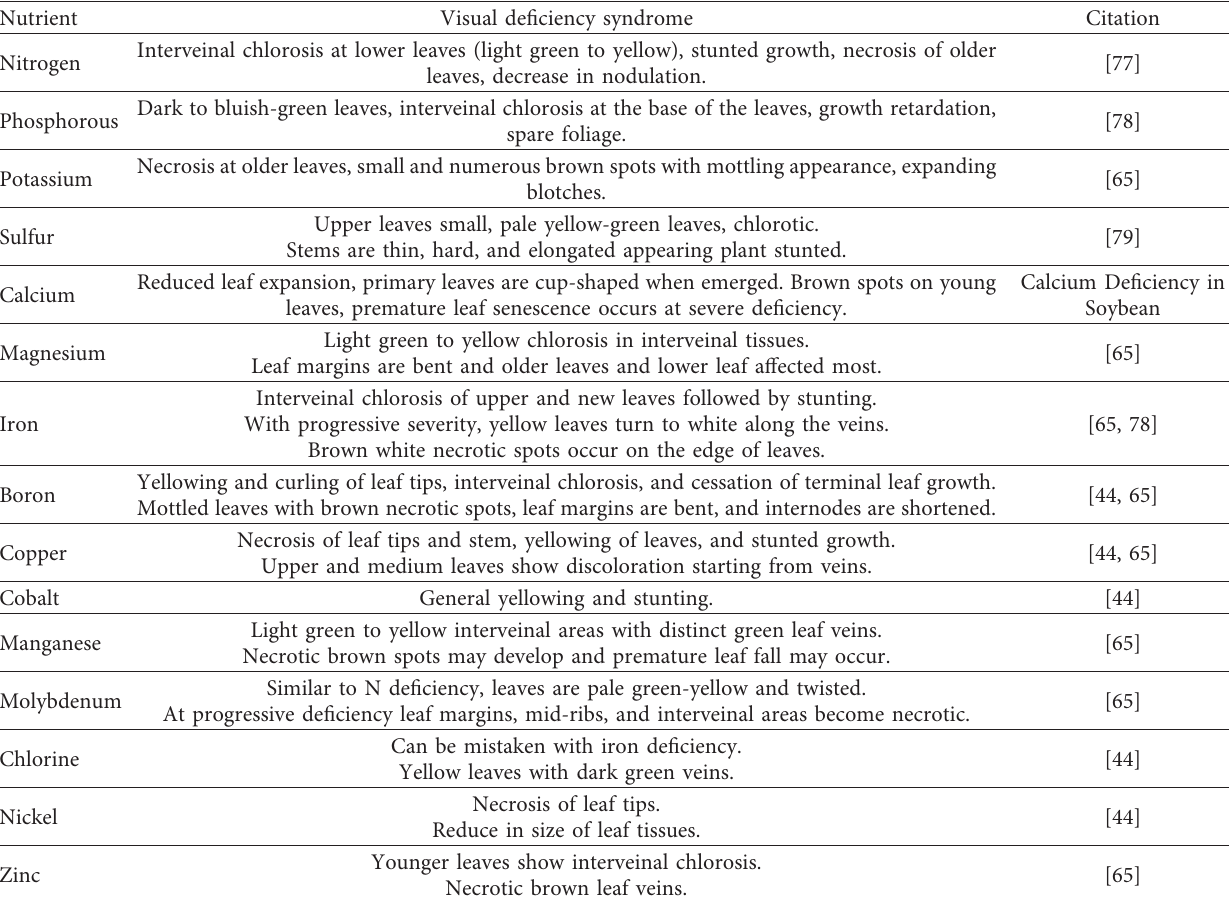
Table 1: Visual symptoms shown by soybean crop during nutrient